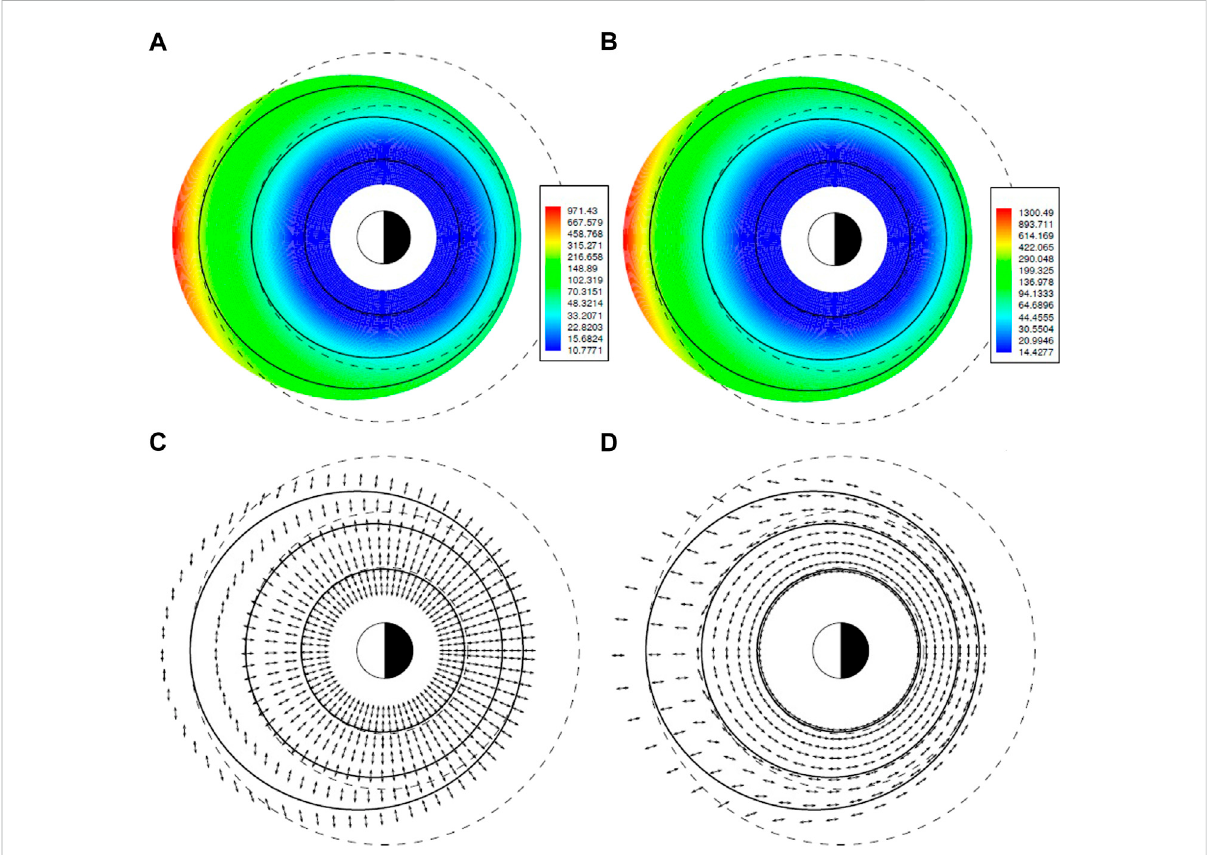
FIGURE 7 Eigenperiodsandelectric fi eldpolarizationsintheequatorialplaneforthetwolowestfrequencyAlfvéniceigenmodes,takenfromFigures3,6of Kabin et al. (2007): (A) Period and (C) polarization of the mode with radial electric fi eld polarization at midnight; (B) Period and (D) polarization of the mode with azimuthal electric fi eld at midnight. Thick solid lines show the contours of constant B initiated at r = 3, 5, and 7 at noon. Dashed lines are circlesofconstantradiuswith r =3,5,and7.Notethesuddenchangeinthepolarizationalongthenoonmeridianat r ≈ 5in (C,D) .Thisoccursat a point of degeneracy in the eigenperiod in (A,B)